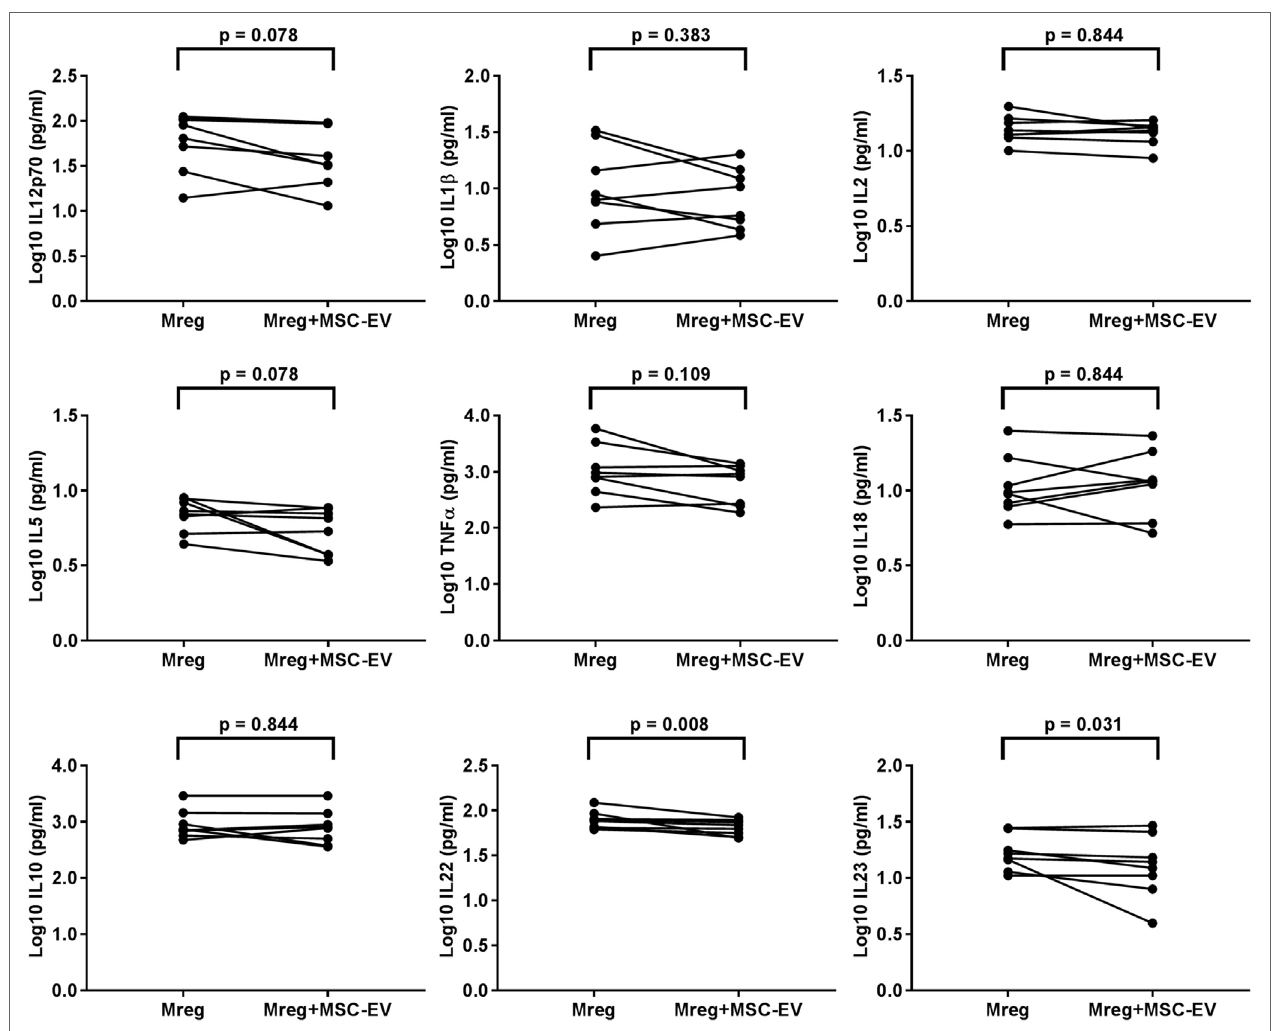
FigUre 4 | Effect of MSC-derived extracellular vesicles on the level of cytokines in Mreg-conditioned media. The media were analyzed for 18 cytokines, and measures within the cytokine-specific detection range were included in the analysis. The values of cell culture media cytokines were log10-transformed. The variation of cytokines between Mreg-conditioned media with and without MSC-EVs was analyzed by the Wilcoxon matched-pairs signed-rank test. The number of biological replicates is 8. Abbreviations: EV, extracellular vesicle; IL, interleukin; Mreg, regulatory macrophage; MSC, mesenchymal stromal cell; MSC-EVs, MSC-derived extracellular